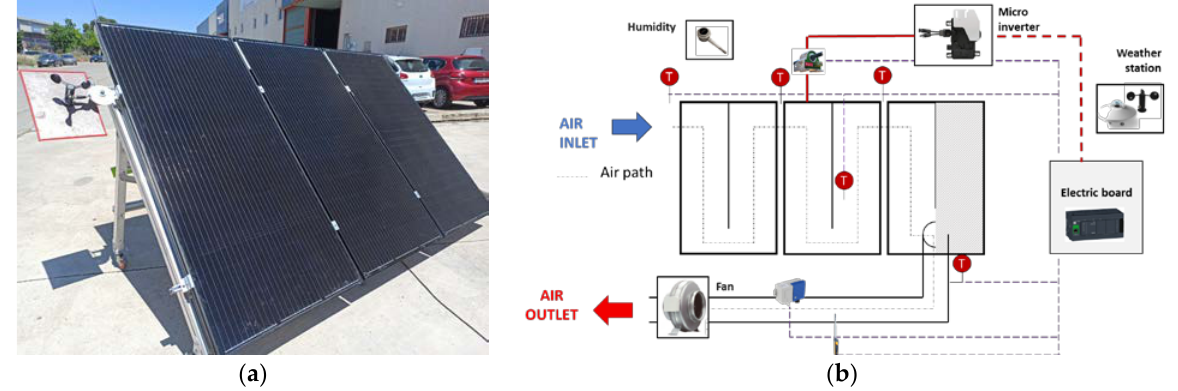
Figure 2. Testing bench of air-based PVT panels: ( a ) Frontal view of real set-up; ( b ) Scheme of set-up with main equipment and sensors.